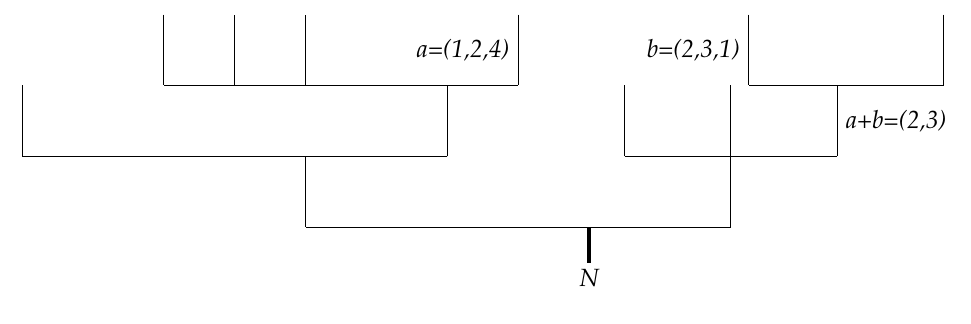
Fig2.Dendrogram of N Figure 2. Dendrogram of